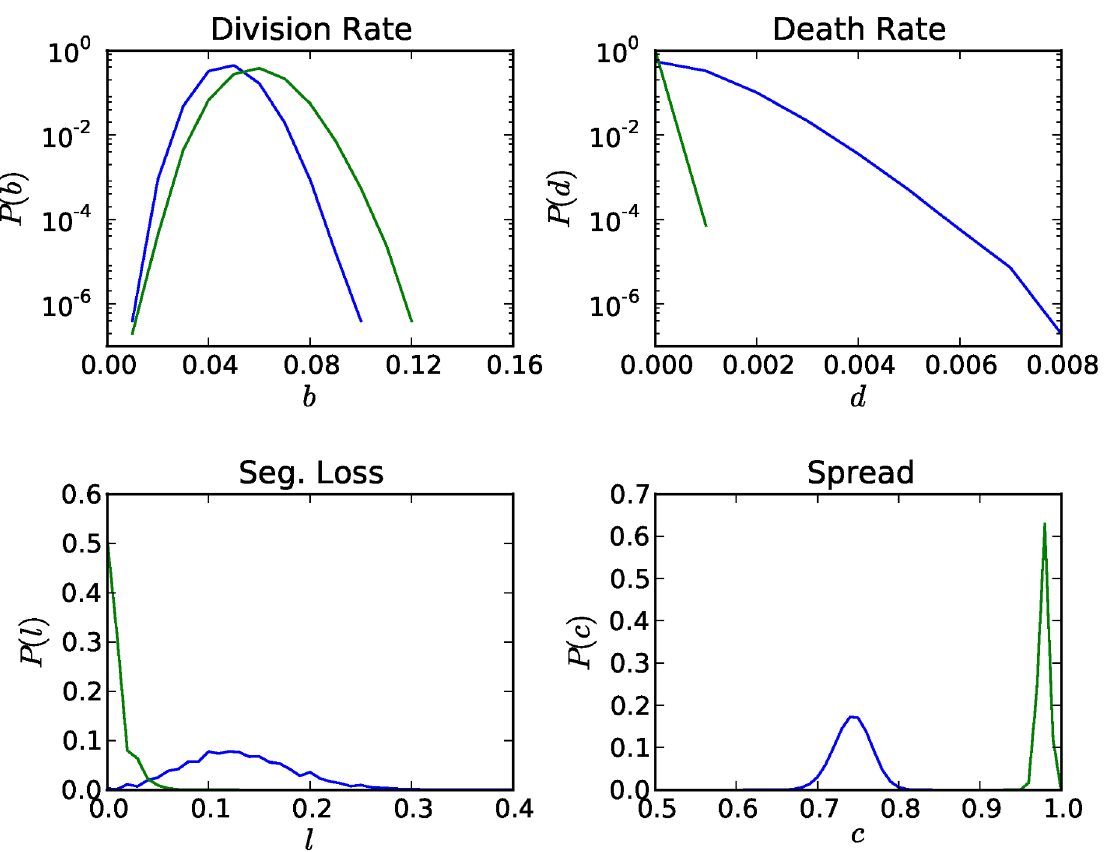
Figure 8. The effects of CNC on host and plasmid performance. Host performance is measured in terms of the division (top left) and death rates (top right), while the performance of plasmids is measured in terms of the segregational losses (bottom left) and the fraction of plasmid- infected hosts in the population (bottom right). The rate of segregational loss is calculated by recording at every time step the instances of a plasmid- free daughter cell arising from a plasmid-infected parent cell among all divisions of plasmid-infected cells. Comparisons are drawn between the baseline model in which policing is absent (NO-CNC in blue color; b evolves, k , a ~ 0 ) and the model in which policing and obedience are allowed to evolve (CNC in green color; b , k , a evolve). The distributions were calculated using the values of the last 100,000 steps of 50 independent stochastic multicellular simulations with the same initial conditions and mutation probability m ~ 10 { 2 .